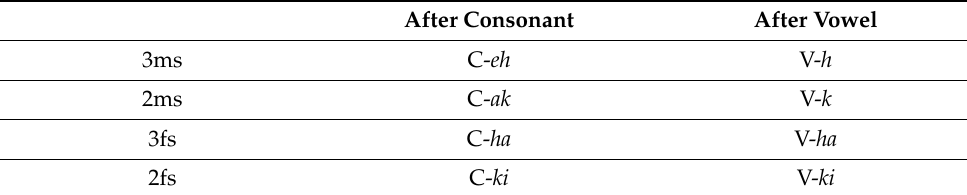
Table 8. The 3rd and 2nd singular pronominal suffixes.